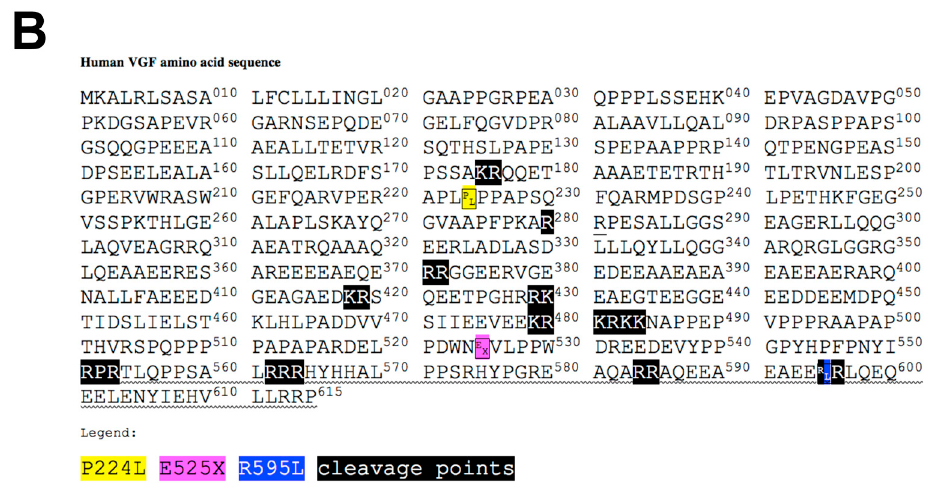
Figure 4. Predicted severity and location of nonsynonymous missense single nucleotide polymorphisms in VGF . ( A ) Three programs were used to identify possible deleterious mutations including PolyPhen-2 Hum Div ( blue ) PolyPhen-2 Hum Var ( red ), Panther ( green ), and SIFT ( gold ). Criteria were a P deleterious for Polyphen-2, Panther value > 0.5, and SIFT value < 0.05. < indicates peptide cleavage site. * indicates SNP pursued in this study. ( B ) Human VGF amino acid sequence. The location of SNPs are indicated by color: yellow = P224L, purple = E525X, blue = R595L, black = cleavage points.